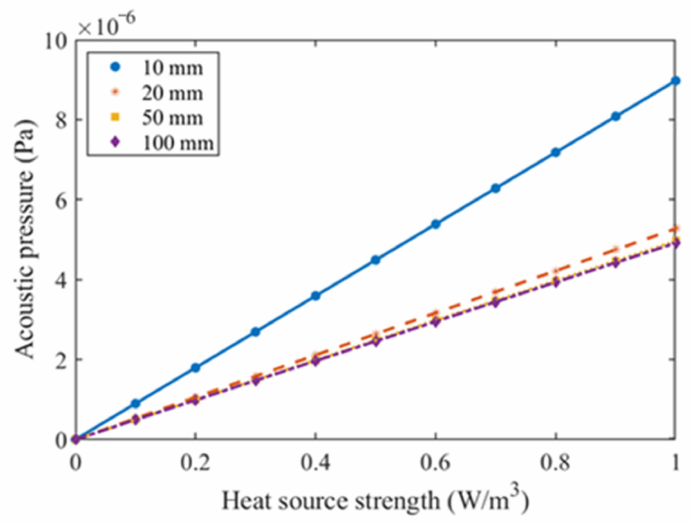
Figure 9. Variation of acoustic pressure with heat source strength at resonant frequency in four bending radius photoacoustic